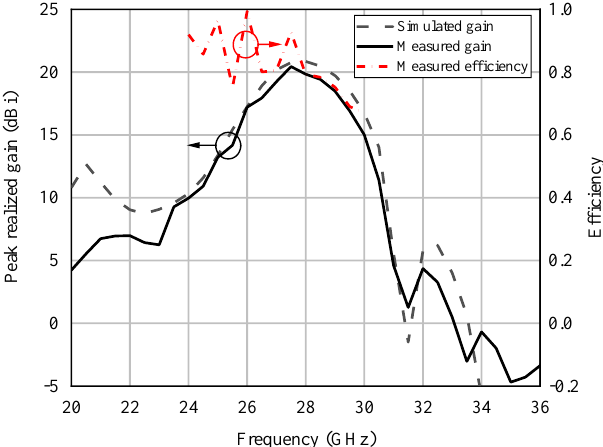
Figure 12. Peak realized gain and efficiency versus frequency.